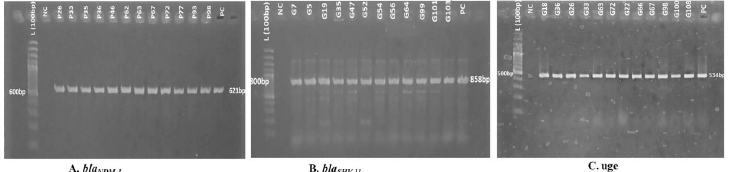
Fig 3. Amplification and confirmation of bla NDM-1 , bla SHV-11 , and uge genes by polymerase chain reaction. PCR products were visualized in 1.5% agarose gel using ethidium bromide staining (0.5%). L indicates Ladder (100 bp); NC as a negative control(Nuclease free water); PC indicates positive control, K . pneumoniae ATCC70603. (A) samples positive amplicons similarly, (B) samples were bla positive representing bands with 621bp were bla NDM-1 SHV-11 amplicons with 858bp, (C) samples were uge positive amplicons having 534bp.